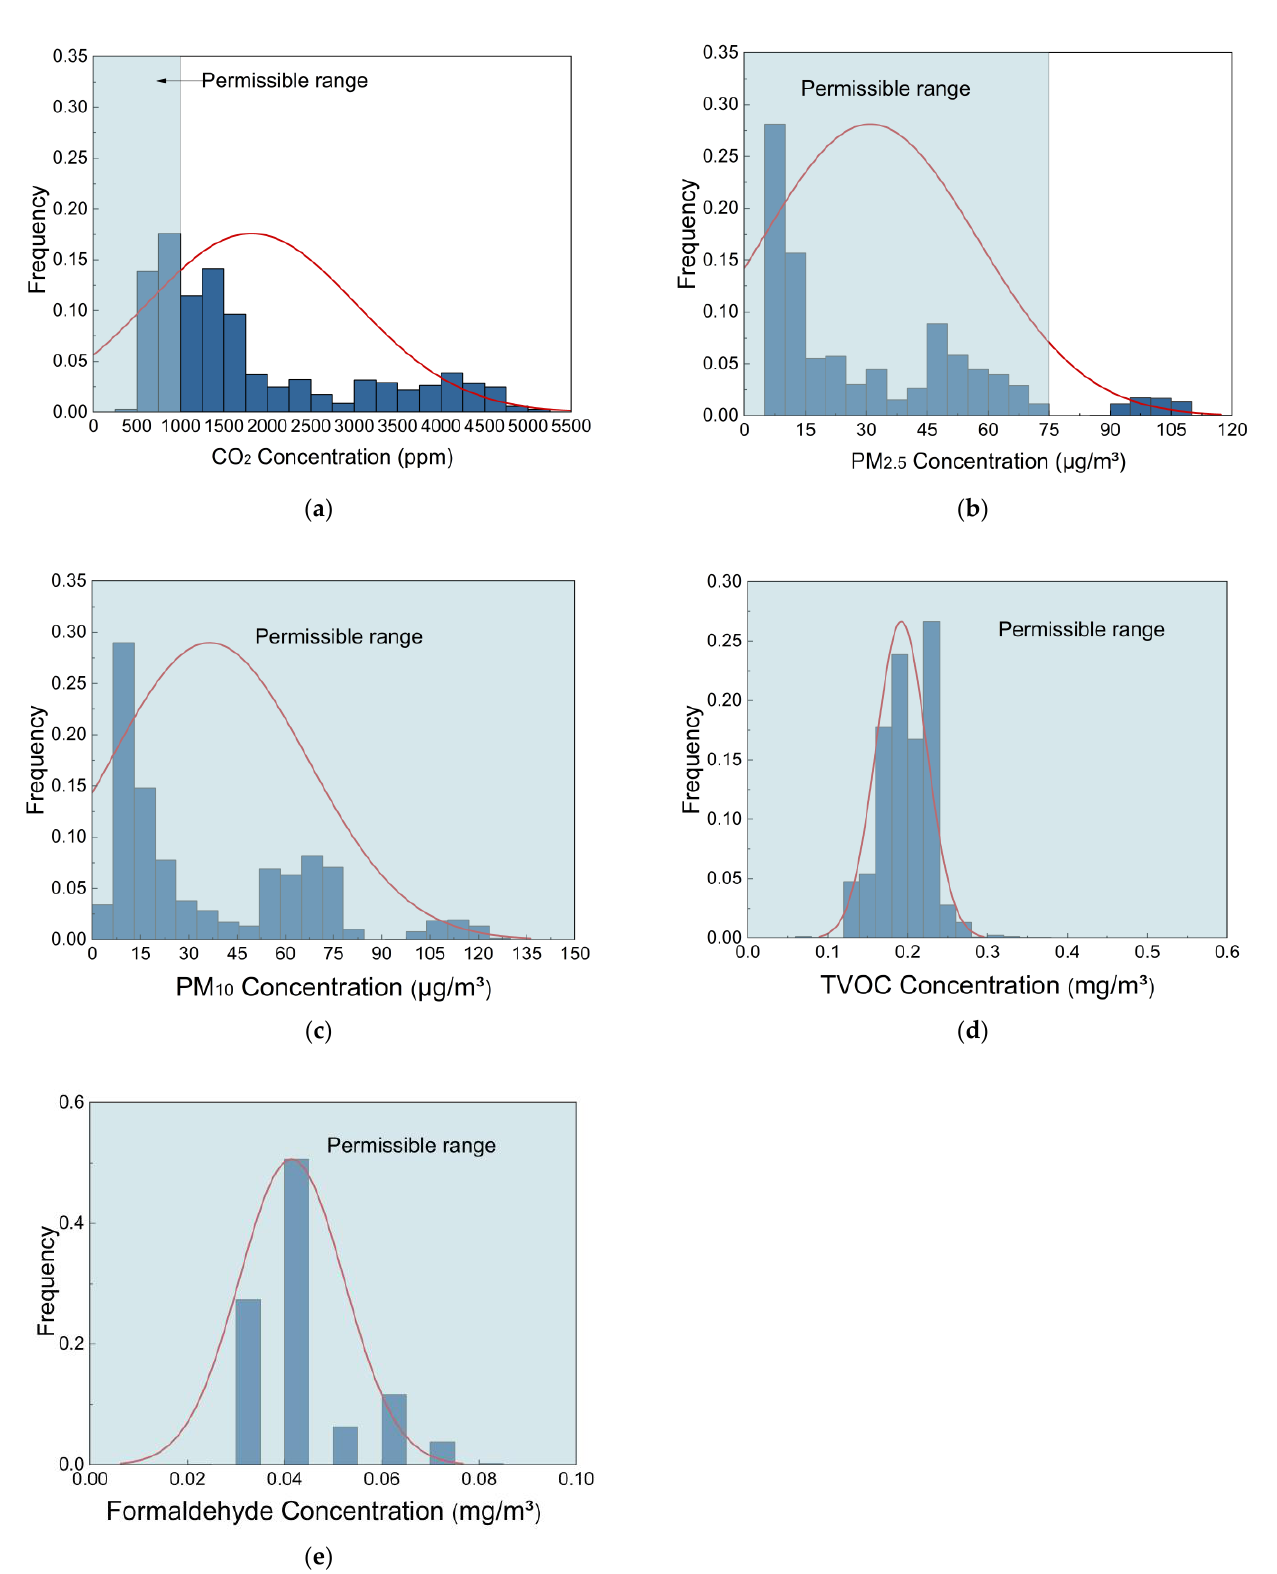
Figure 3. Histograms of IAQ parameters: ( a ) CO 2 ; ( b ) PM 2.5 ; ( c ) PM 10 ; ( d ) TVOC; ( e ) formaldehyde.